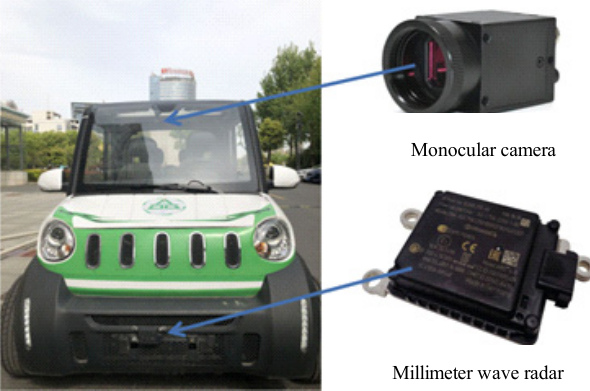
Figure 1. Radar and camera installation locations.